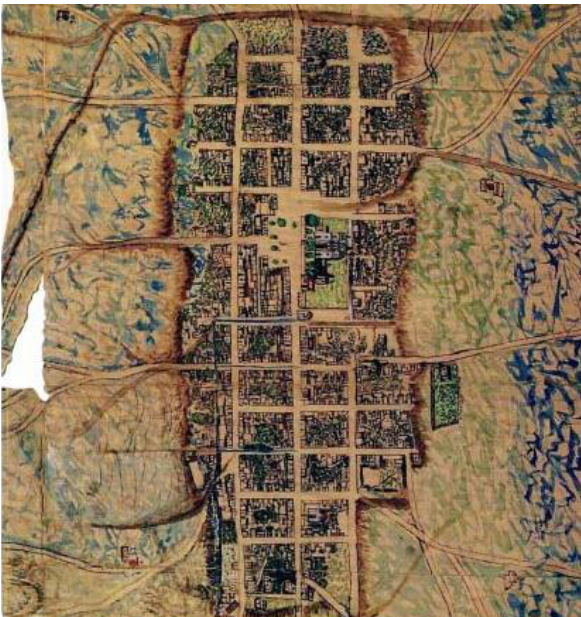
Figure 2. Sketch of the municipality of Calimaya made by C.L.F. ca. 1824. (Source: Atlas of the State of Mexico).